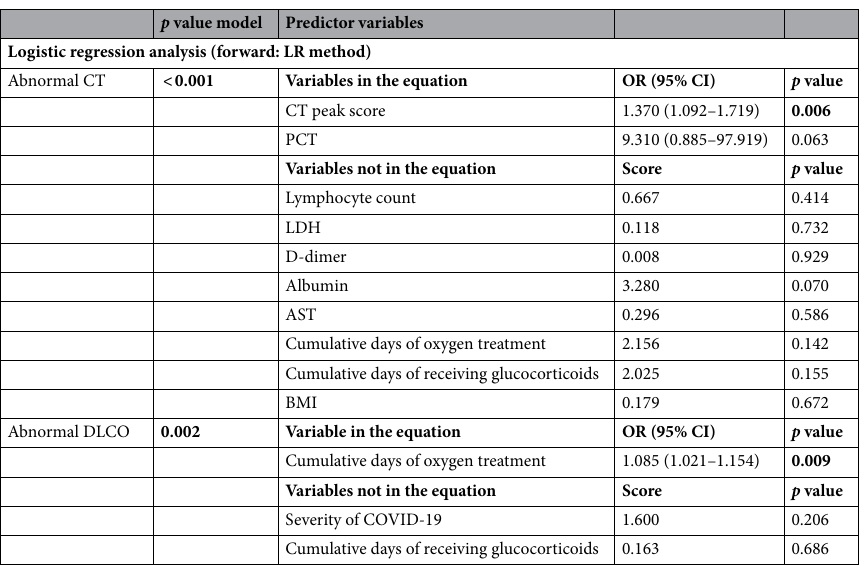
Table 5. Logistic regression analysis of predictors of abnormal CT or DLCO at eight months of follow-up. Quantification and assignment: Abnormal CT: “1” for CT score ≥ 5, and “0” for the opposite; PCT: “1” for > 0.05 ng/mL, and “0” for the opposite; Abnormal DLCO: “1” for DLCO% predicted < 80%; “0” for the opposite. CI confidence interval, PCT procalcitonin, LDH lactate dehydrogenase, AST aspartate aminotransferase, BMI body mass